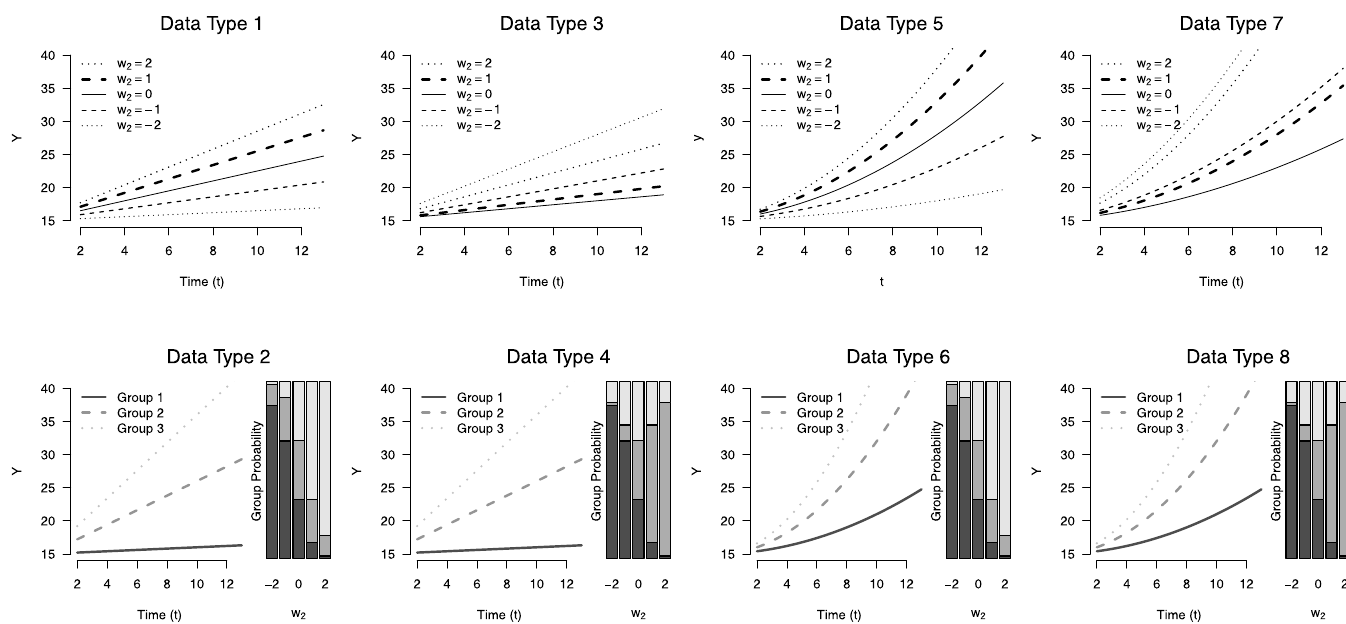
Fig 5. Conditional mean outcomes for simulation study data generation. For data types 1, 3, 5, and 7, the means are conditional on the quantitative exposure value of w 2 and for data types 2, 4, 6, and 8, the means are conditional on the subgroups and the group probabilities for given exposure values are on the right.